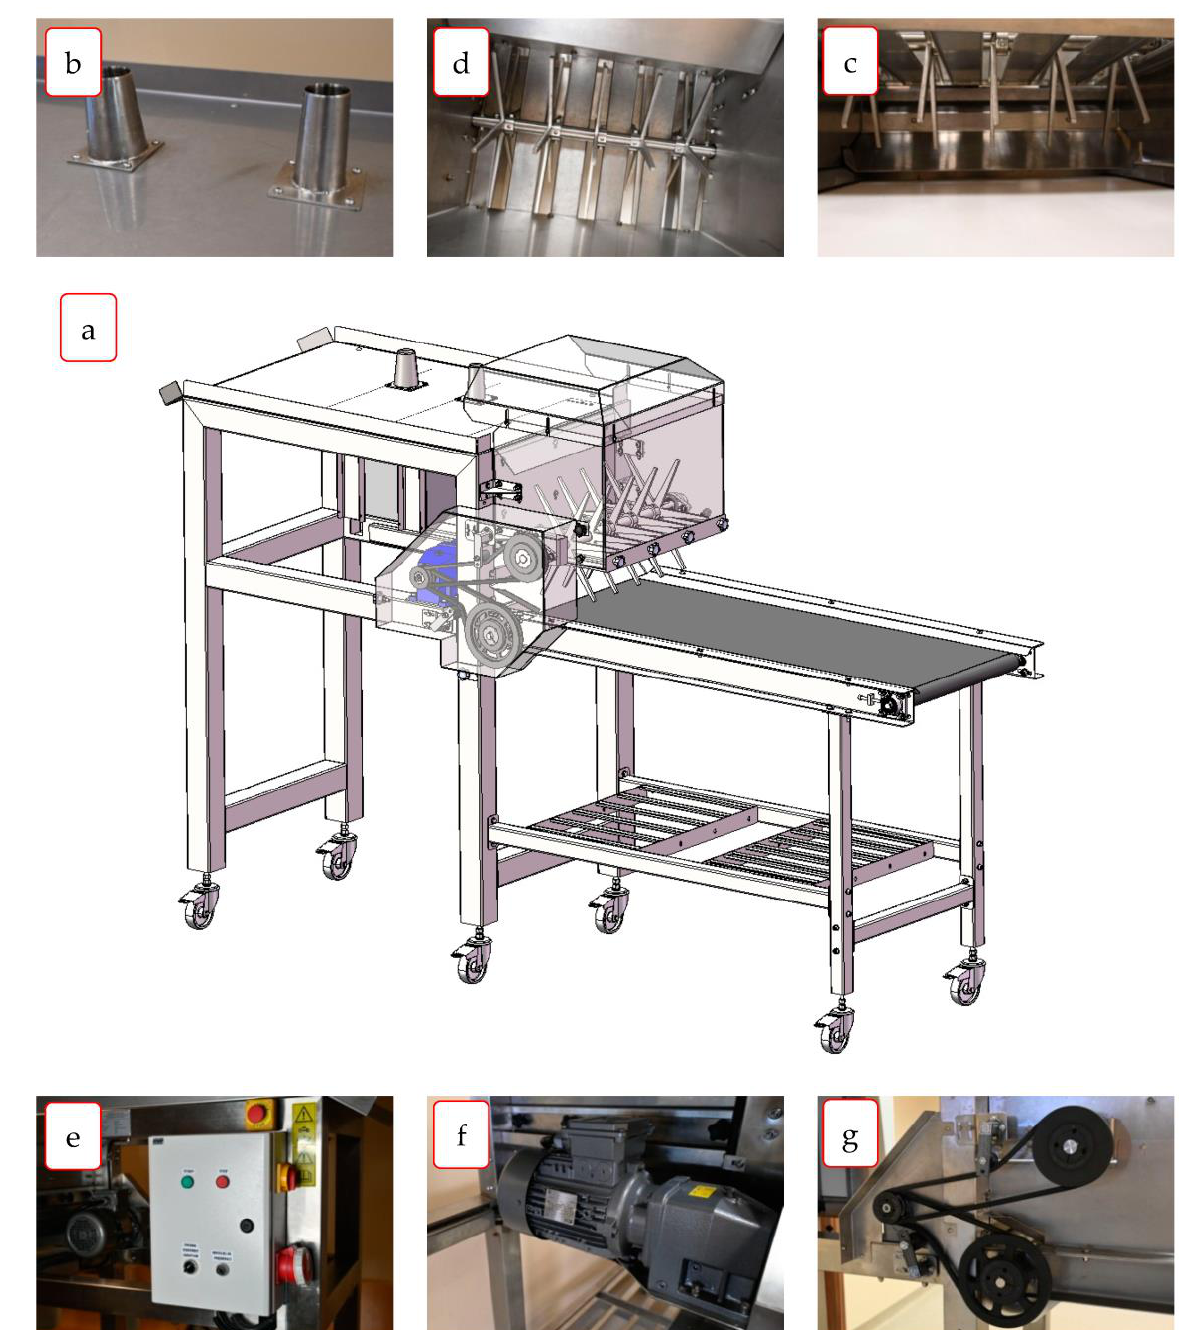
Figure 4. Prototype of the designed vegetable crusher: ( a ) general view; ( b ) floretting knives; ( c ) crushing chamber; ( d ) screen at the bottom of the crushing chamber; ( e ) power control box, ( f ) electric motor; and ( g ) V-belts.